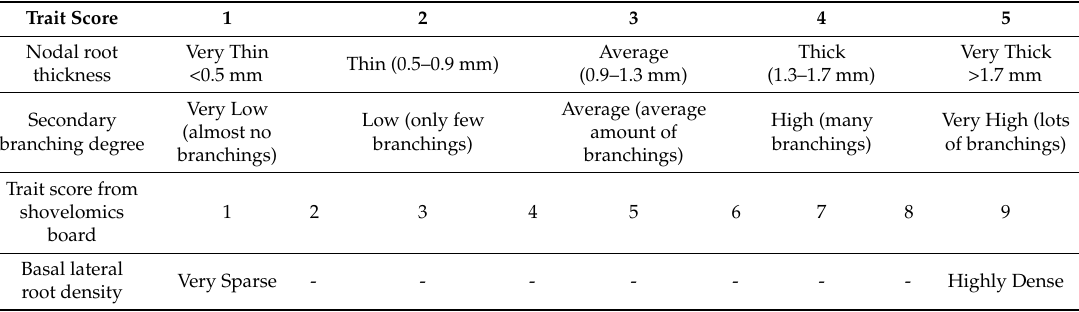
Table 2. Scoring values used for evaluating architectural root traits in both pot and field trials. Trait